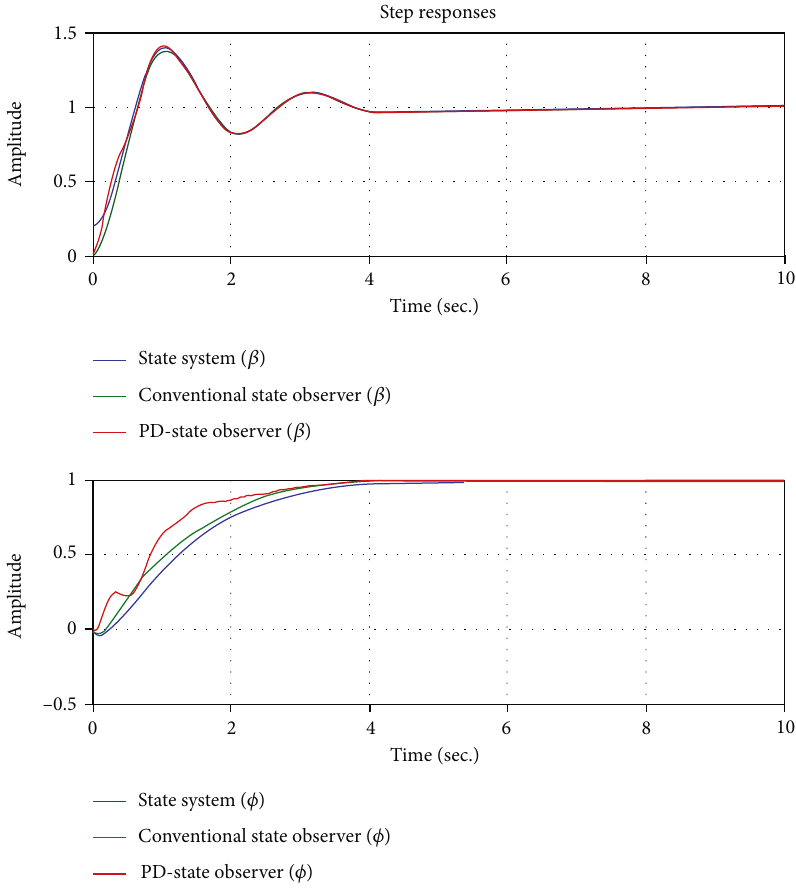
Figure 4: Simulations of state observer with: α = 10 I